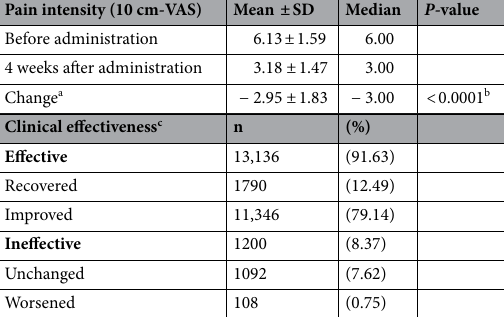
Table 4. Effectiveness of aceclofenac CR (N = 14,336). CR controlled release, VAS visual analogue scale, SD standard deviation. a Change = 4 weeks after administration – before administration. b Wilcoxon signed-rank test. c Recovered: All signs and symptoms of pain have disappeared, and no further treatment is deemed necessary, Improved: Signs and symptoms of pain are judged to be significantly improved, Unchanged: No changes in signs and symptoms of pain are observed, and Worsened: Signs and symptoms of pain recurred or